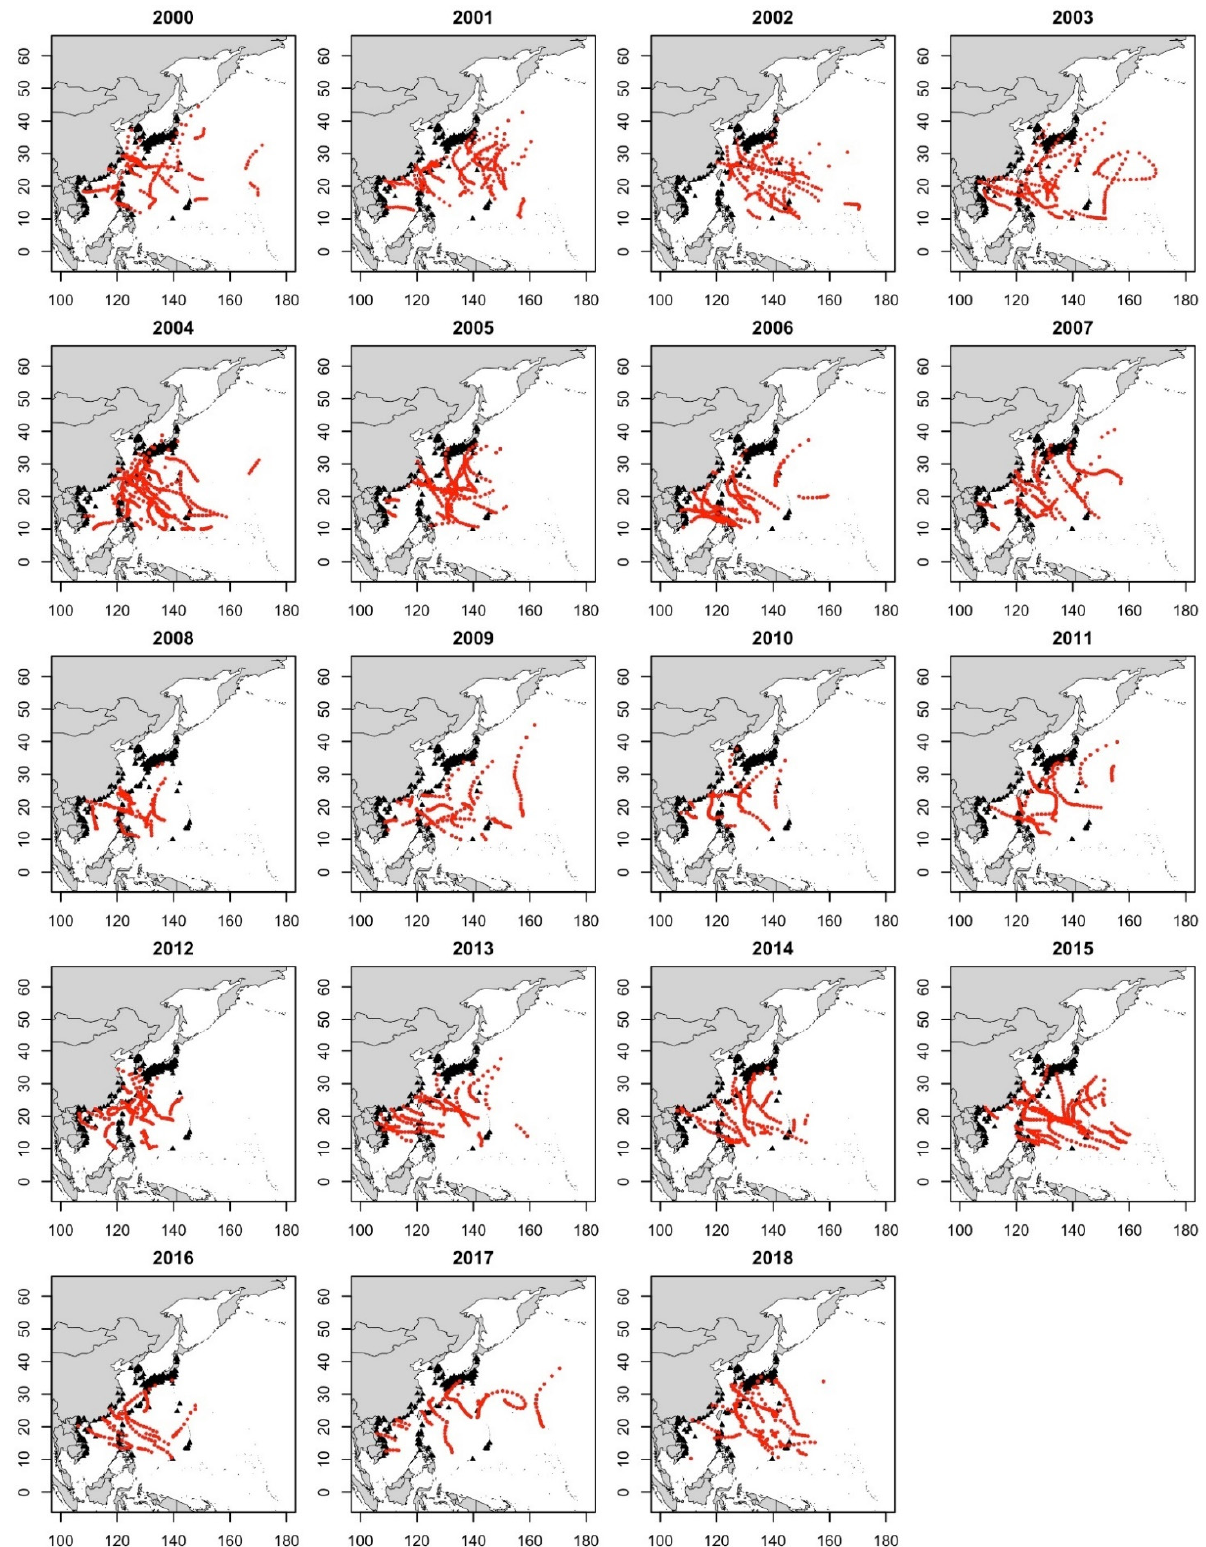
Figure 1. Maps showing best tracks for typhoons for each year from 2000 to 2018. Center locations shown for the typhoons (red circles) and stations (black triangles).